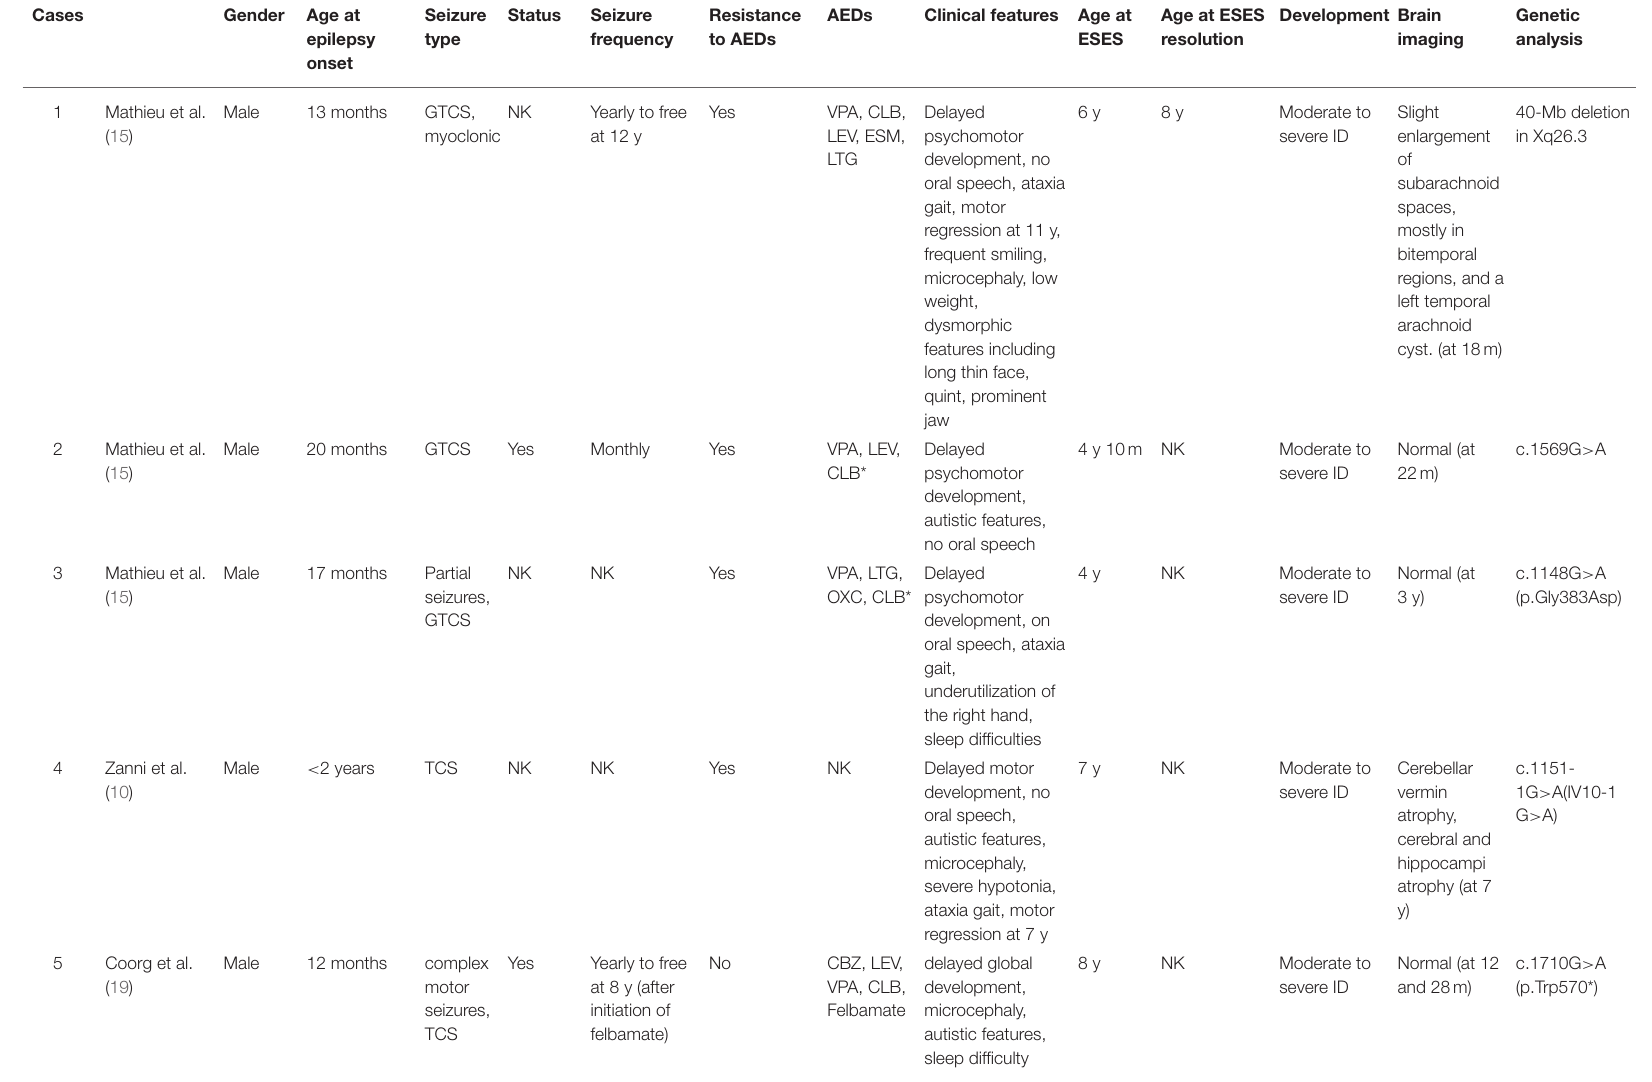
TABLE 2 | Clinical characteristics of 8 cases of CS with